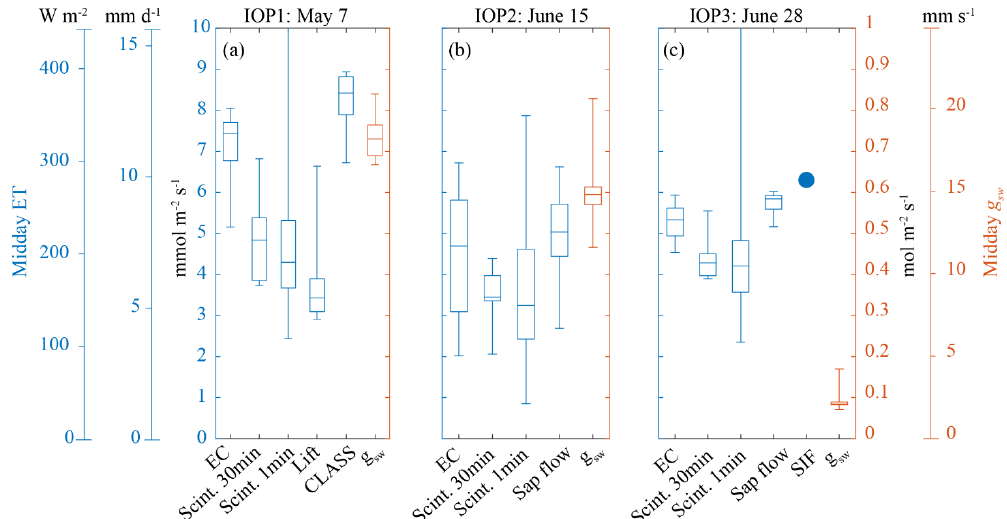
Figure 17. Summary of midday evapotranspiration collected using different instrumental techniques during (a) IOP 1, (b) IOP 2, and (c) IOP 3. ET fluxes (left y axis) and g sw (right y axis) reflect the period from 09:00 to 14:00UTC. Box plots denote the variability in 30min measurement intervals, except for the 1min scintillometer measurements. The central mark of each box indicates the median, and the bottom and top edges of the box indicate the 25th and 75th percentiles, respectively. The acronyms are eddy covariance (EC), scintillometer (Scint) with 30min and 1min averages, ET inferred from the lift profiles (Lift), sap flow, ET calculated with the CLASS model, and ET inferred from the sun-induced fluorescence